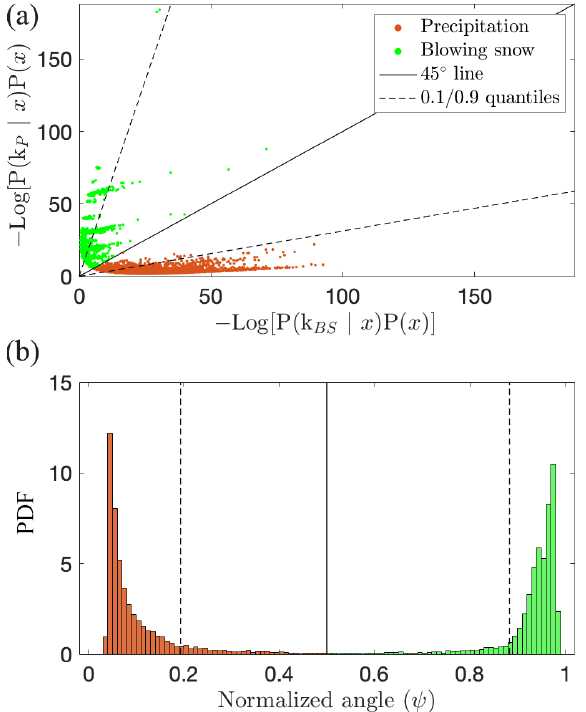
Figure 9. (a) Scatter plot of the quadratic discriminant values of both components for the training set. (b) Probability density func- tions (PDF) of the normalized angle for the precipitation and blow- ing snow subsets and thresholds to identify mixed images.